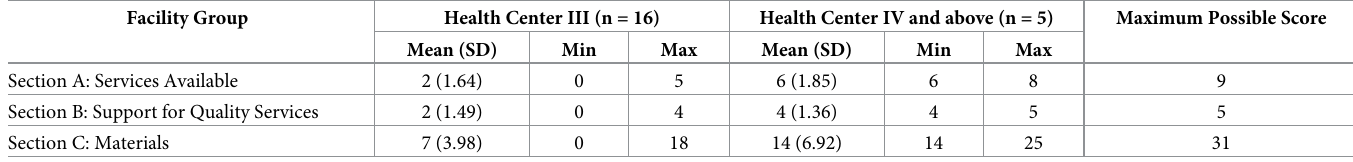
Table 3. Simple statistical scoring by facility level